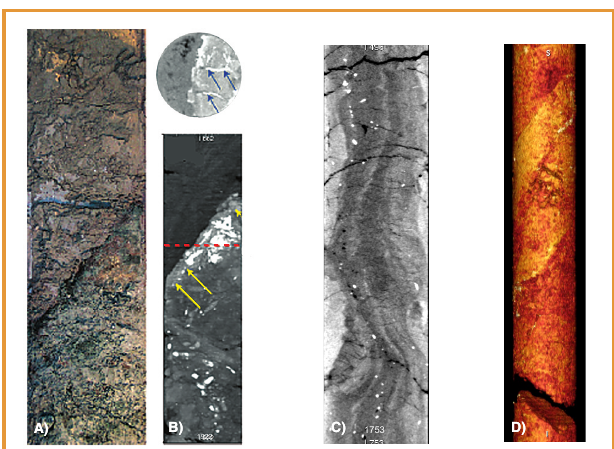
Figure 5. Left: Selected X-Ray CT images. Left: the relationships that can be seen between the core photos and the CT images; Yellow and blue arrows indicate the position of the clear discontinuity seen in both core and CT image, with bright areas corresponding to mineralized material. The red line in the along-core CT image shows the position of the slice in the upper right. Spatial and angular relationships can be determined with high precision using core orientation. Middle: X-Ray CT imagery can be used to evaluate coring induced or drilling induced deformation or disruption of the core sample. This image shows flow-in of fluidized mud that occured during core recovery of a piston core. Right: False color imagery based on CT-number (density contrasts related to pore spaces, water content, and mineral chemistry) can be used to highlight structural features such as this set of normal faults (cutting the core from top right to bottom left in this image). In all cases, cores are 2.5 inches across.